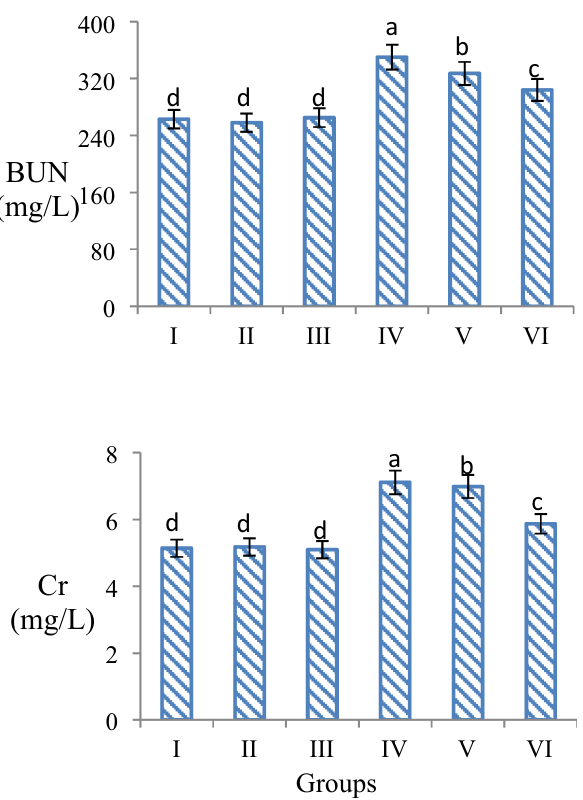
Figure 5. Effects of AFM 2 and quercetin on serum BUN and creatinine levels. Group I: control, Group II: 25 mg/kg b.w quercetin, Group III: 50 mg/kg b.w quercetin, Group IV: 16 mg/kg b.w AFM 2 , Group V: 16 mg/ kg b.w AFM 2 + 25 mg/kg b.w quercetin, Group VI: 16 mg/kg b.w AFM 2 + 50 mg/kg b.w quercetin. Means shown with different letters (a–d) are statistically significant ( p <